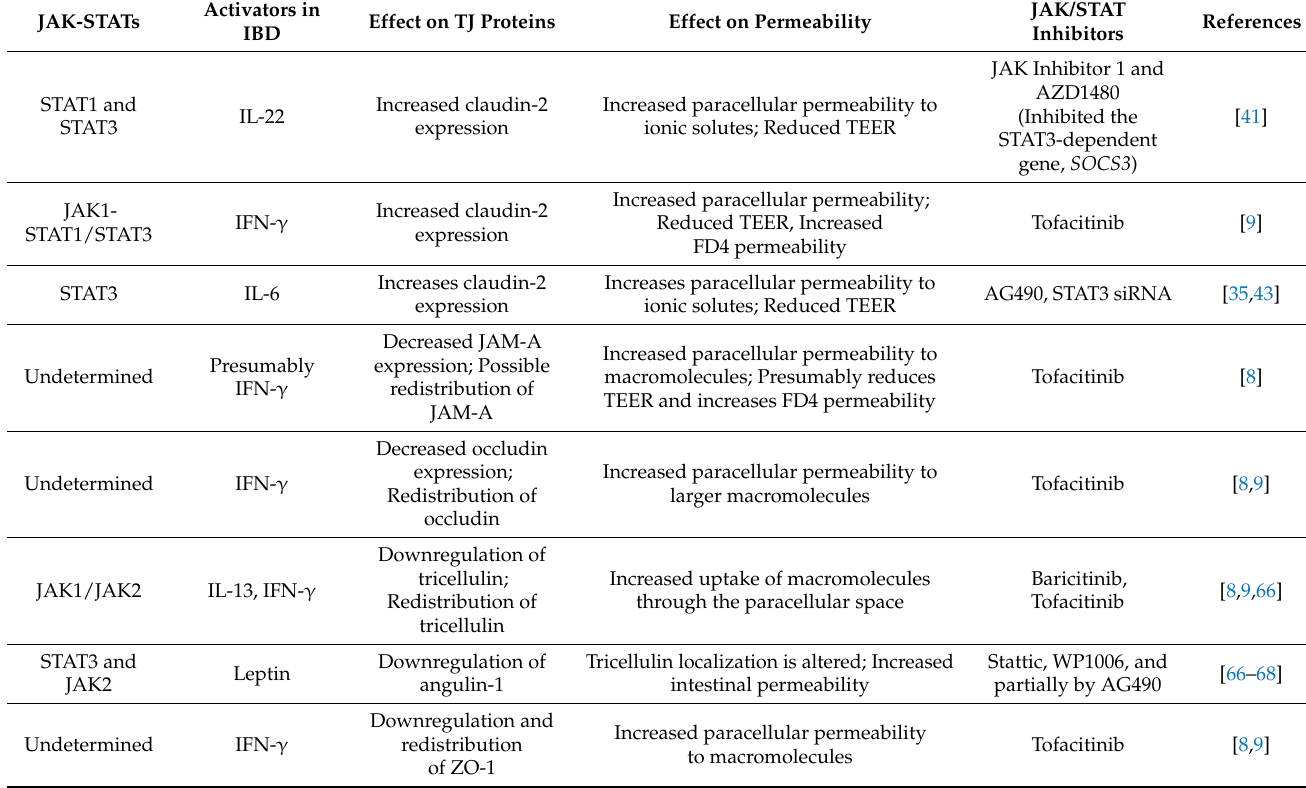
Table 2. JAK-STAT signaling pathways affecting intestinal permeability. (JAK: Janus Kinase, STAT: Signal Transducer and Activator of Transcription, IL-22: Interleukin 22, IFN- γ : Interferon gamma, IL-6: Interleukin 6, IL-13: Interleukin 13,